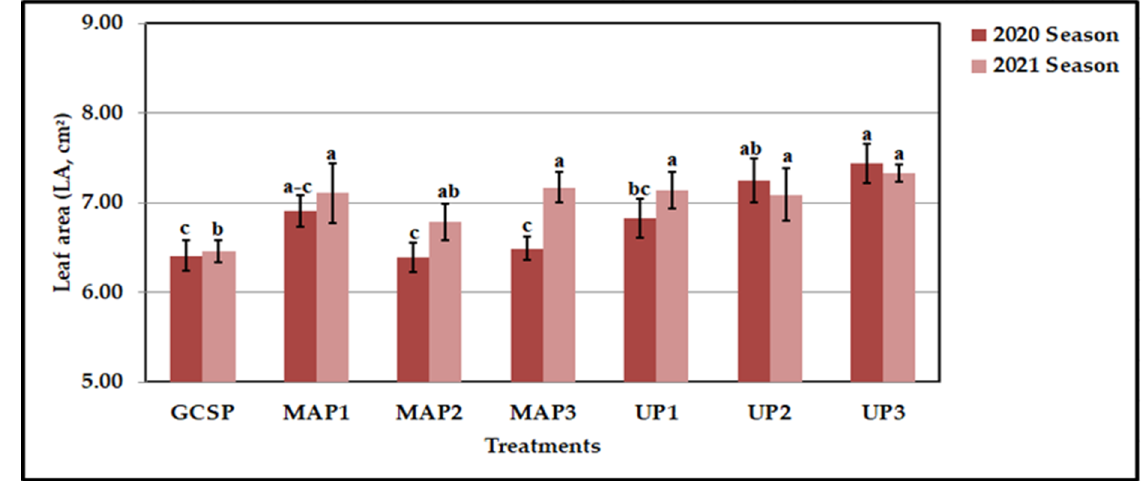
Figure 4. Influence of phosphorus fertilizers; mono-ammonium phosphate (MAP and urea phosphate (UP) applied to leaf area (LA, cm 2 ) of olive (arbequina cv.) trees grown in sandy loam clay soil under multi-abiotic stresses (CaCO 3 = 8.8 vs. 9.2%, ECe = 6.4 vs. 7.2 dS m − 1 , and pH = 7.78 vs. 7.89) during 2020 and 2021 seasons. GSCP applied represents 1.75 kg tree − 1 , MAP 1 , MAP 2 , and MAP 3 represent MAP applied at 0.336, 0.445, and 0.555 kg tree − 1 , and UP 1 , UP 2 , and UP 3 represent UP applied at 0.465, respectively. 0.616 and 0.770 kg tree − 1 . Bars in the same years with a different letter indicate significant differences between treatments at p ≤ 0.01. According to Duncan’s multiple range test, bars sharing the same letter in each column are not signi fi cantly different .